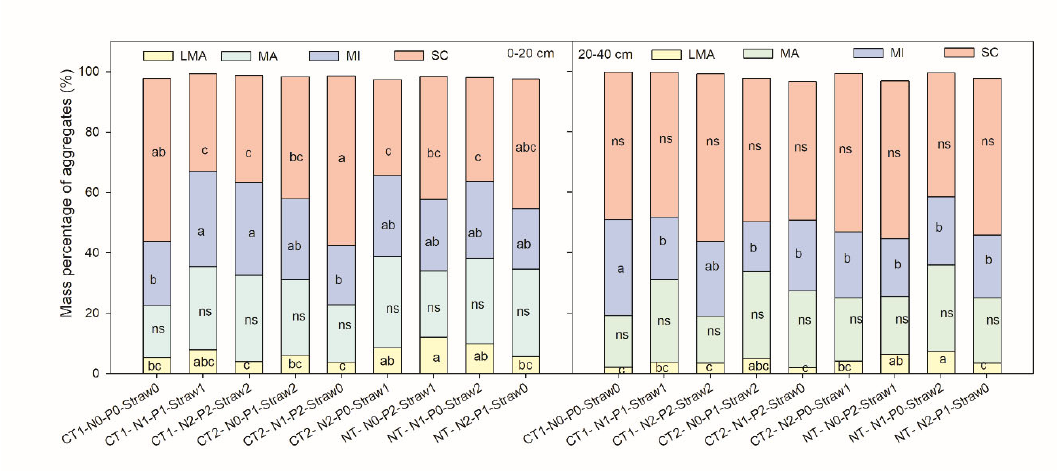
Figure 1. Mass distribution of four different size aggregates (>2, 0.25–2, 0.053–0.25, and <0.053 mm) under tillage and fertilization treatments from 0–20 and 20–40 cm. Similar letters between treatments within a soil layer are not significantly different according to Tukey’s HSD test. CT 1 turned straw into the soil and CT 2 covered straw on the surface.